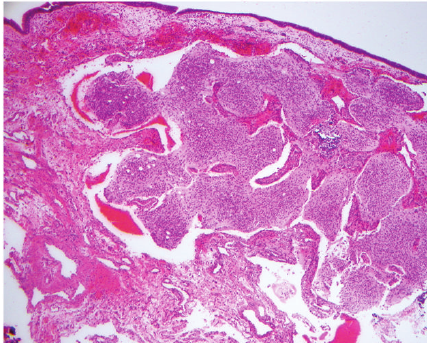
Figure 1: T2 weighted MRI with gadolinium showing enhancing mass in left lateral nasal wall and maxillary sinus.